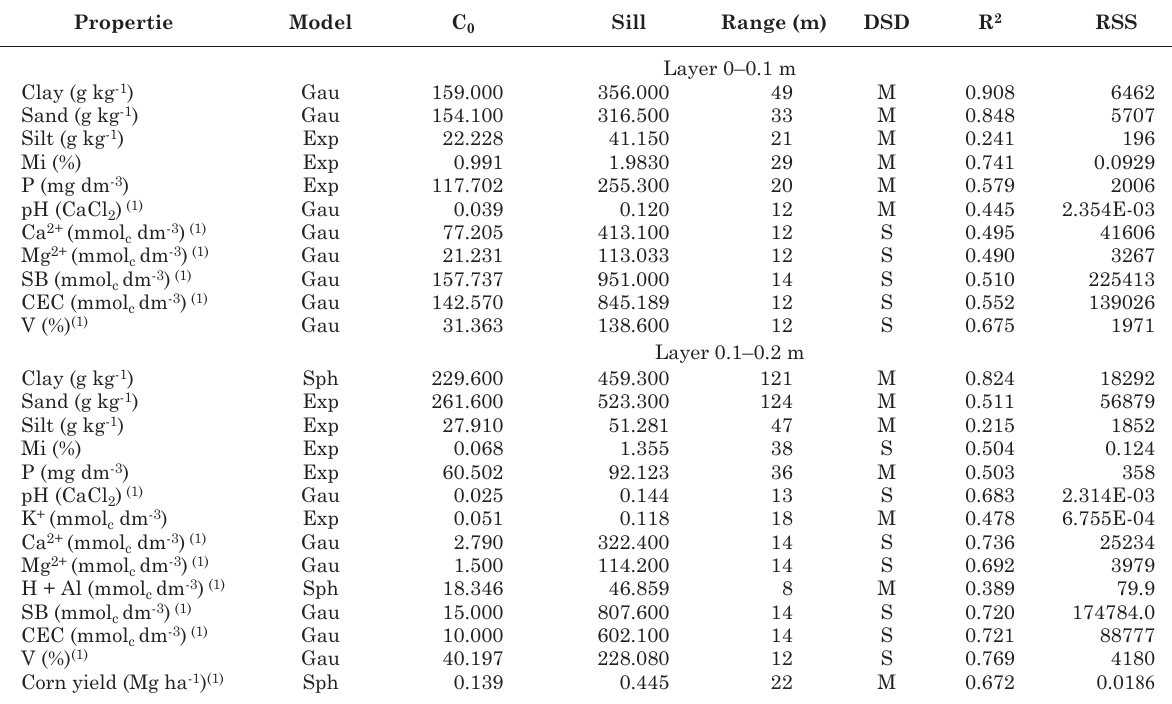
table 4. Variogram model parameters of soil properties in the 0–0.1 and 0.1–0.2 m layers and for corn